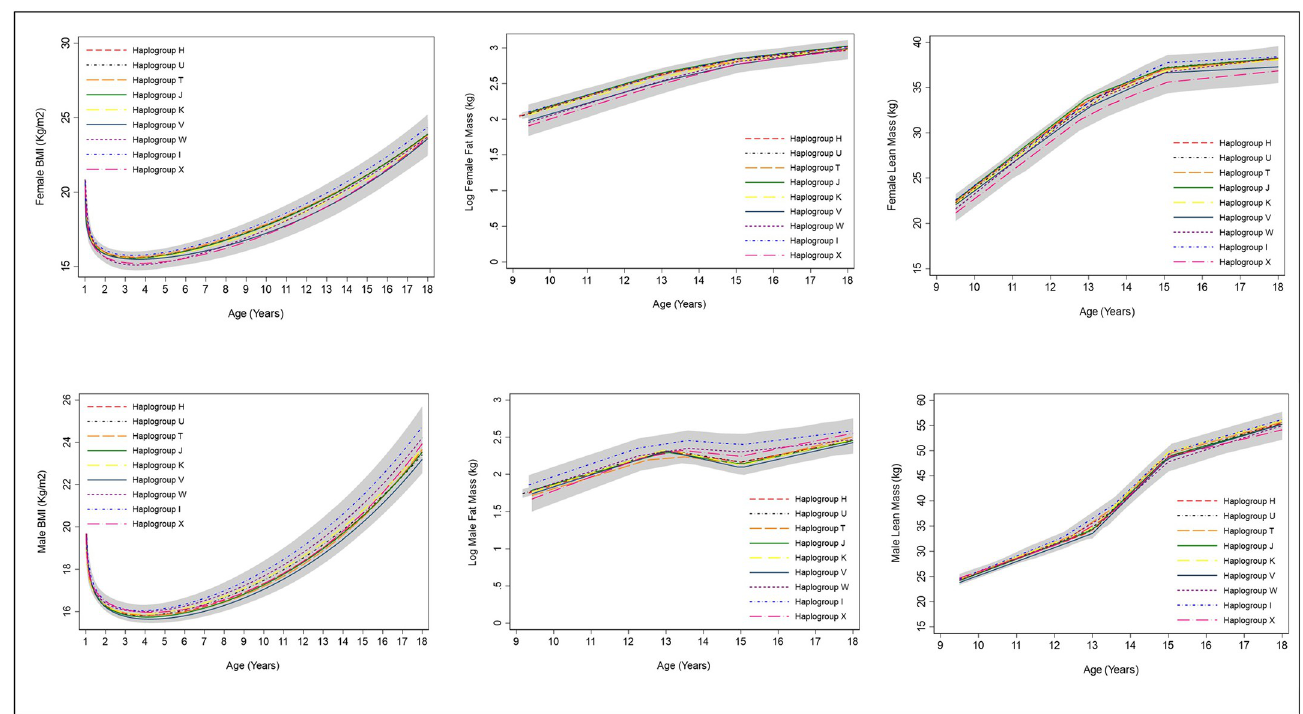
Fig 1. Mean trajectories of BMI, log fat mass and lean mass in females and males, by haplogroup. 99% confidence intervals for all haplogroups are displayed in grey. Note the different age range on the X axis for each outcome. Detailed results with confidence intervals are provided in S12-S14 Tables in S1 File. BMI, body mass